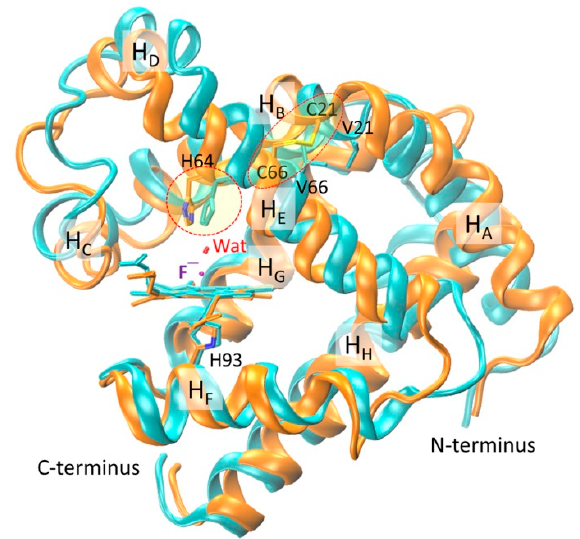
Figure 3. Overlap of modeling structures of fluoride–WT Mb (cyan) and fluoride–V21C/V66C Mb (orange) complexes. The heme group, proximal His93, axial fluoride ion, distal water, N- and C-terminus, and eight α -helices (H A –H H ) are highlighted for clarifications. The conformation of distal His64 and the disulfide bond of C21 – C66 are indicated by dashed circles.